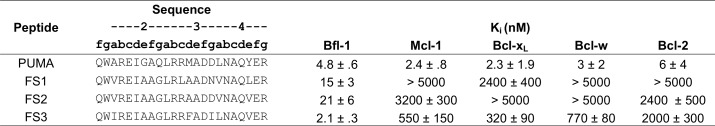
Peptide affinities for Bfl-1, Bcl-xL, Mcl-1, Bcl-2 and Bcl-w.Ki obtained from competition assays with fluoresceinated BIM peptide. Data are mean ± SD of three replicates.